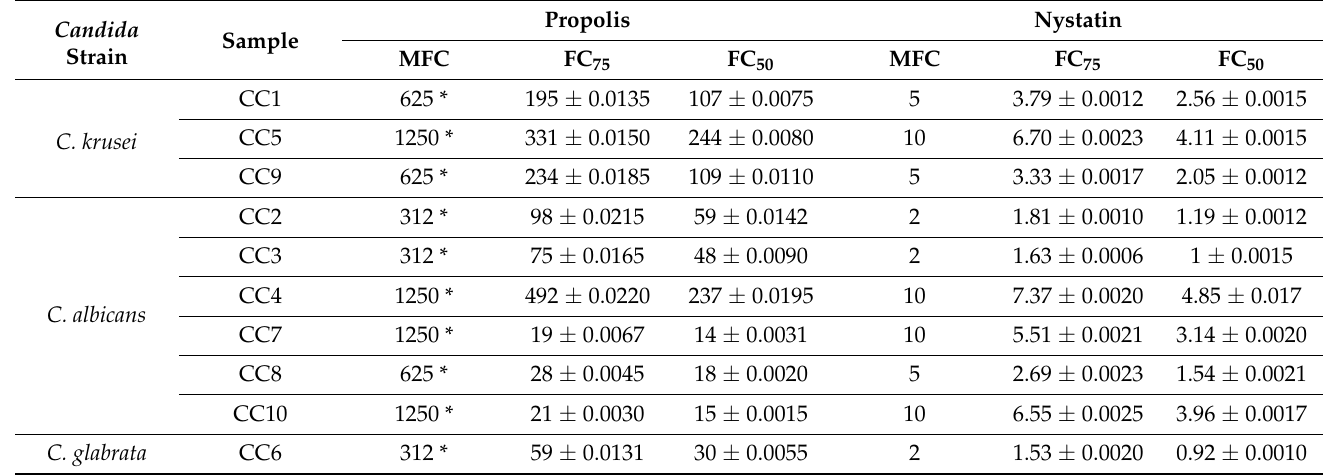
Table 2. Quantitative evaluation of the anti- Candida activity of Mexican propolis.